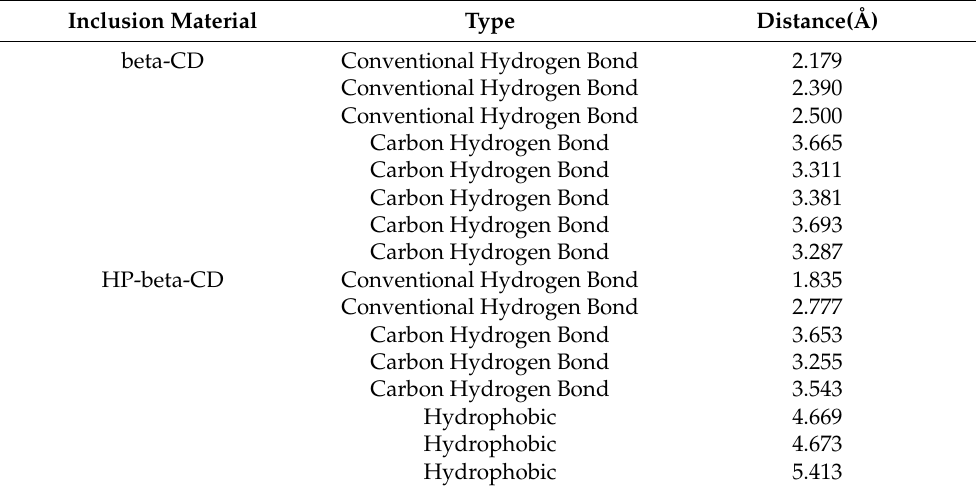
Table 4. Nonbonding force and distance between OL and beta-CD and HP-beta-CD molecules. Inclusion